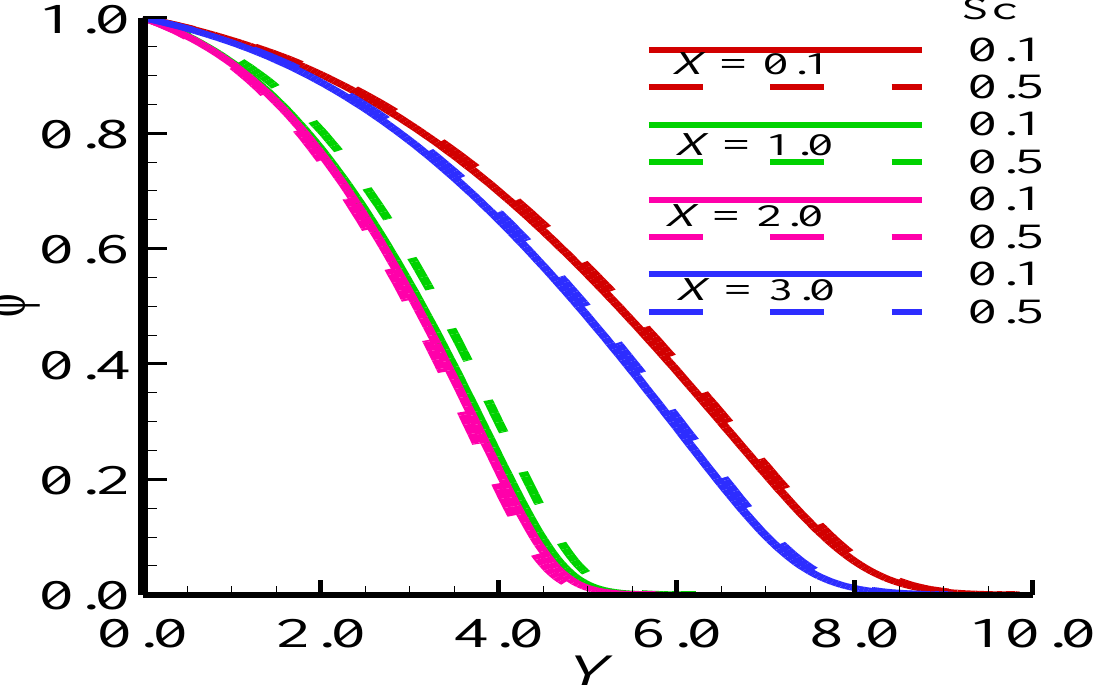
Figure 11. Outcomes of Schmidt number 𝑆𝑐 on mass concentration 𝜙 when 𝑁 = 0.5,𝑁𝑏 = 1.5,𝑁𝑡 = 1.5, and 𝑃𝑟 = 7.0.